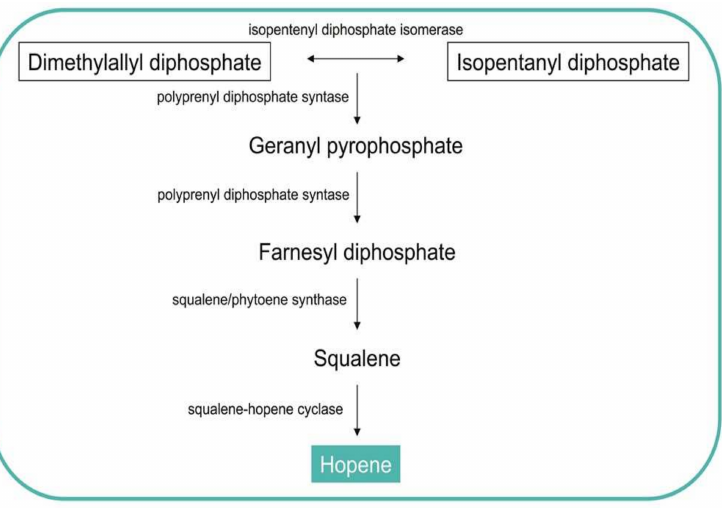
Figure 4. Metabolic pathways for the synthesis of Hopenes.